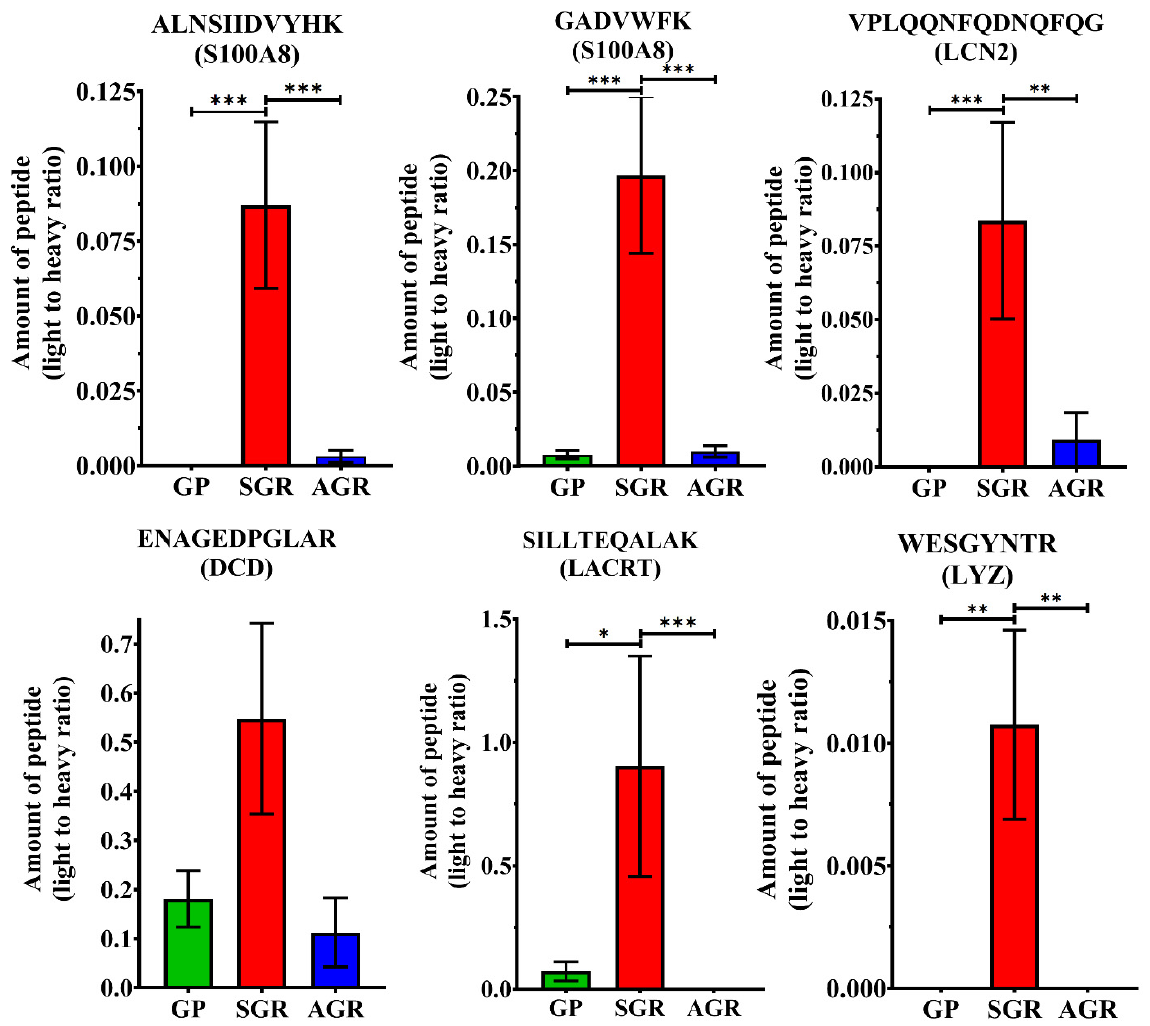
Figure 4. The protein level of examined AMPs in different skin regions. On the ‘y’ axis the mean ± SEM interval of light to heavy ratios were plotted for the skin regions shown on ‘x’ axis. * indicates statistically significant difference (* p < 0.05; ** p < 0.01; *** p < 0.001). GP: sebaceous and apocrine gland poor; SGR: sebaceous gland rich; AGR: apocrine gland rich skin areas.